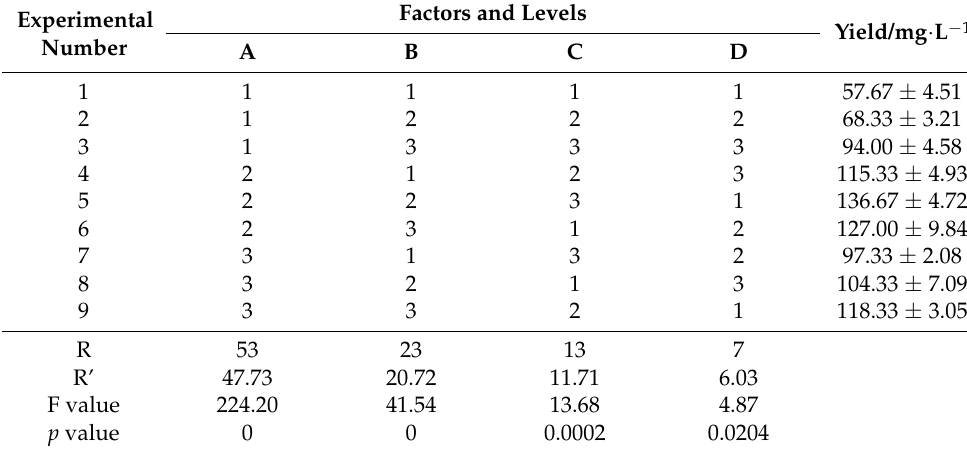
Table 6. The result of L9(3 4 ) orthogonal design.